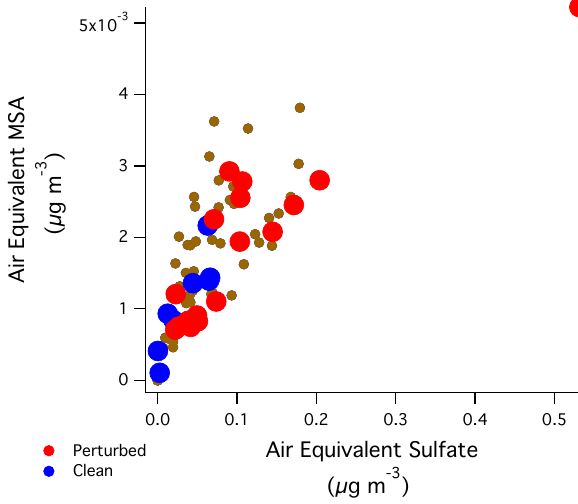
Fig. A1. Variation of air equivalent MSA and sulfate in cloud wa- ter droplets. Red markers represent measurements made during per- turbed flights (RF 14–18), blue markers represent measurements made during clean flights (RF 5–8). Brown markers are all other measurements.